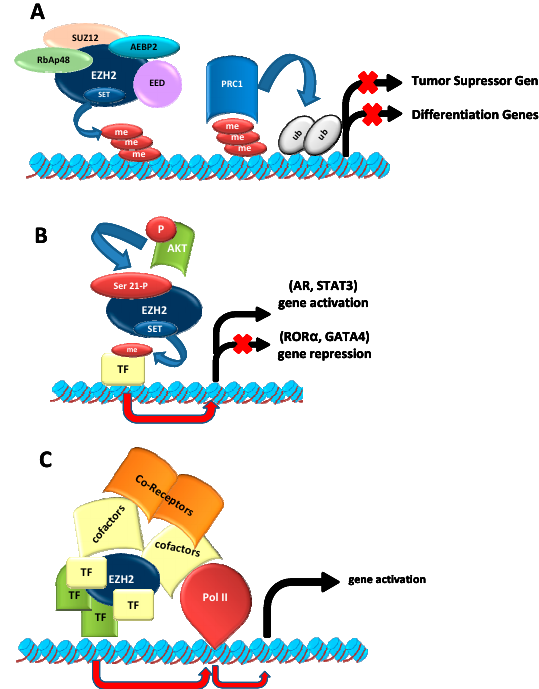
Figure 1. Canonical and non-canonical function of EZH2. ( A ) EZH2 as epigenetic silencer. EZH2 trimethylates lysine 27, and to a lesser extent, lysine 9 of histone H3 through its SET domain. These marks are recognized by PRC1, which monoubiquitynates lysine K119 on histone H2A, compacts the chromatin, and consequently represses gene transcription. In addition, EZH2 can induce tumor suppressor silencing and tumor progression; ( B ) PRC2-independent methylation of non-histone proteins. When EZH2 is phosphorylated by AKT in serine 21, it can methylate other proteins such as androgen receptor (AR), or transcription factors like Signal Transducer and Activator of Transcription 3 (STAT3), to activate gene transcription, or it can methylate other factors, such as Retinoid-related Orphan Receptor α (ROR α ) or cardiac factor GATA-binding factor 4 (GATA4), to repress transcription; and ( C ) Methyltransferase-independent EZH2 functions. EZH2 can act as scaffold protein for various transcriptional factors, such as estrogen receptors (ER) or components of the WNT/ β -CATENIN signaling pathways to promote gene transcription (see references in the text). EZH2: Enhancer of zeste homolog 2; SUZ12: zing finger protein suppressor os zeste 12; EED: embryonic ectoderm development; SET: conserved domain Su (va) 3-9 Enhancer of Zeste and Trithoax; RbAp48: retinoblastoma-binding protein 48; AEBP2: adipocyte enhancer binding protein 2; AKT: is a serine-threonine specific protein kinase; TF: Transcription Factor. me: methylation; Ub: ubiquitynation; P: phosphorylation; Pol II: RNA polymerase II. The red arrows indicate induction of transcription. The black arrows mean the activation of gene transcription. The black arrow with a red cross means the repression of gene transcription. The light blue cylinders are histones, and the red ribbons are DNA.